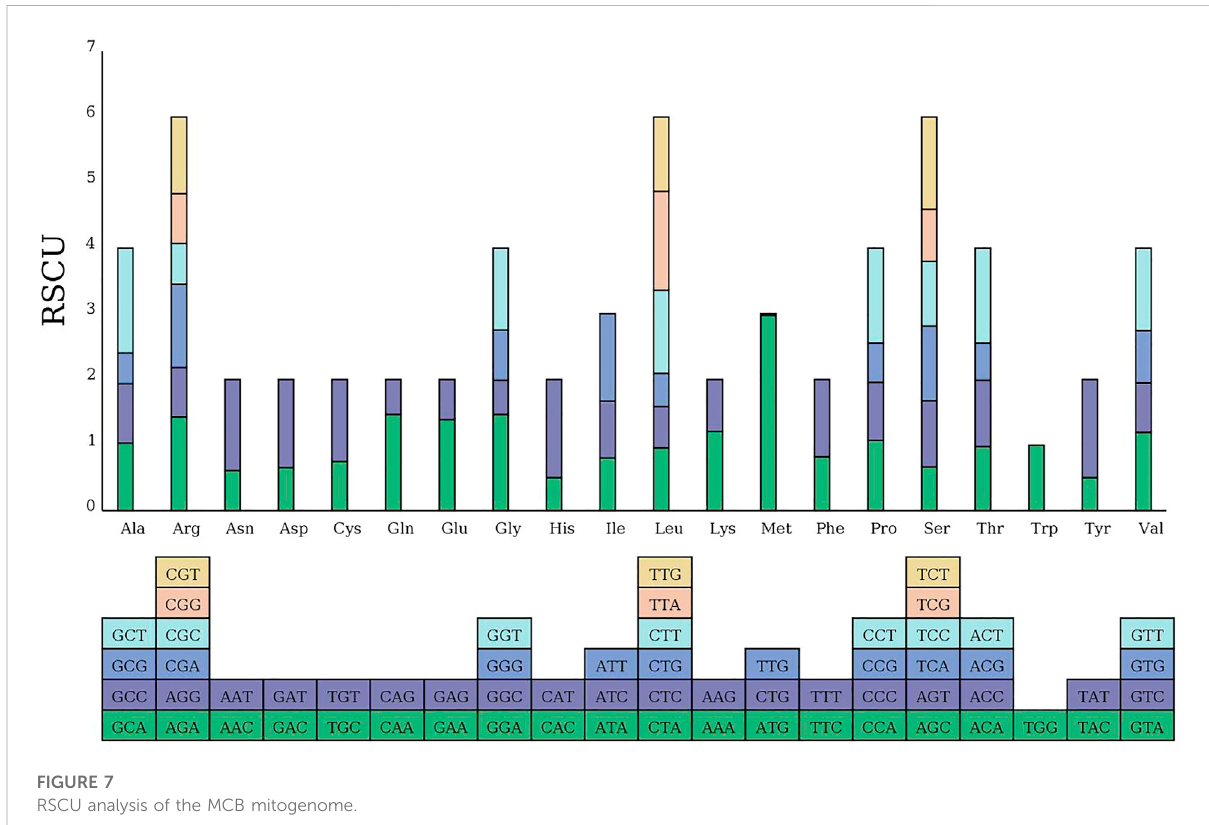
FIGURE 7 RSCU analysis of the MCB mitogenome.